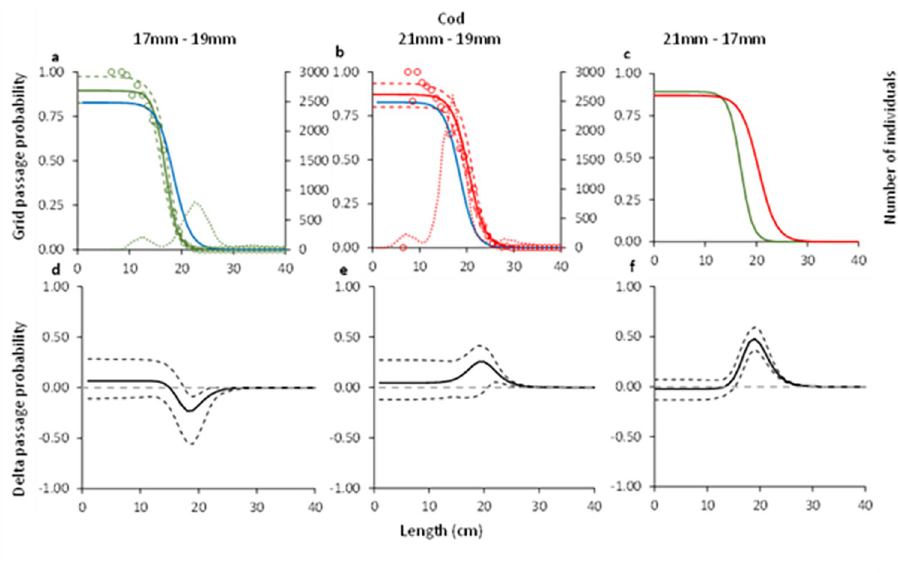
Fig 3. Grid passage probability for cod (a-c). Circles illustrate experimental rates, solid curves represent the fitted model, and stippled curves are the 95% CI’s. Green lines and circles represent the data for grid with 17 mm bar spacing, red– 21 mm grid spacing, and blue line–grid with 19 mm grid spacing. Dotted green and red lines represent total population size structure retained by the gear. Plots d-f show the difference in the length-dependent grid passage probability (delta) between the different grids with 95% CI’s (stippled lines).